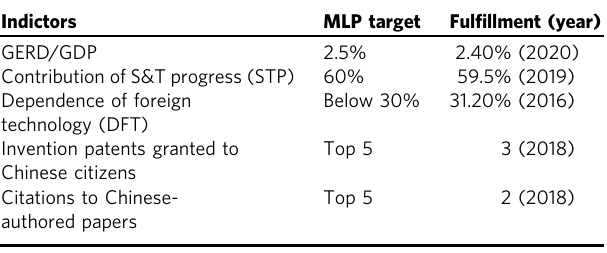
Table 1 The targets set in MLP and their ful fi